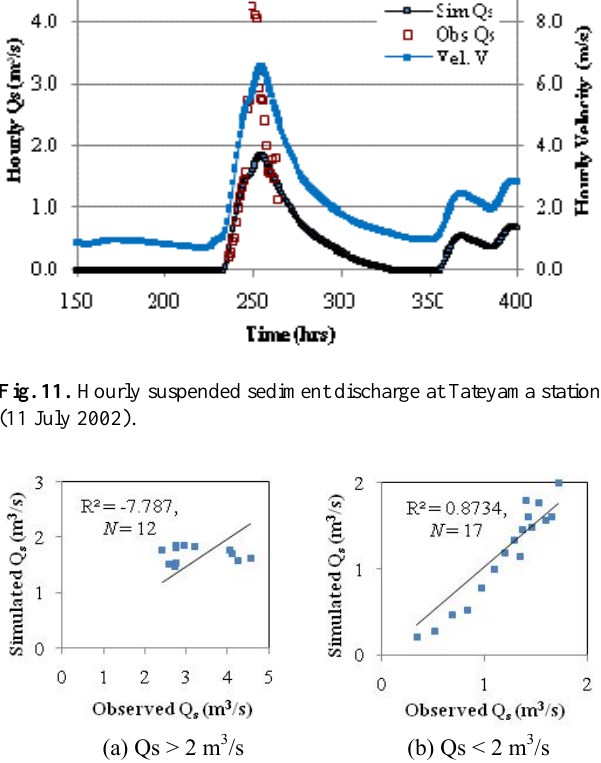
Fig. 12. Correlation of observed and simulated hourly suspended sediment discharge at Tateyama station ( N = number of observa-